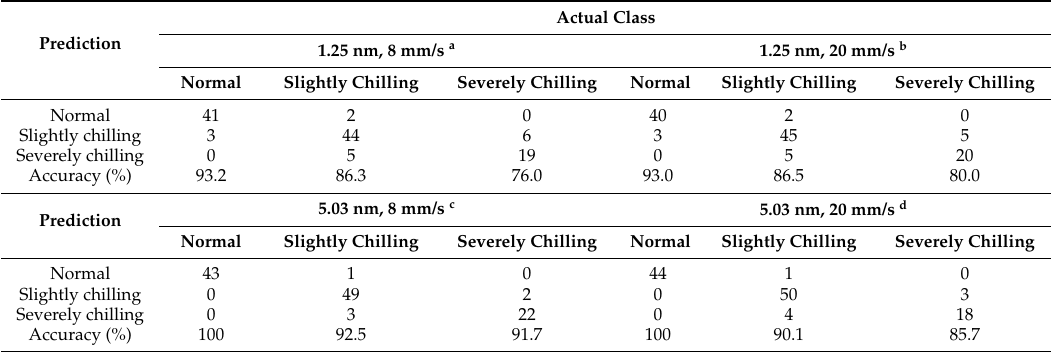
Table 2. Confusion matrixes of different combinations of scanning speeds and spectral resolutions based on the optimal number of spectral